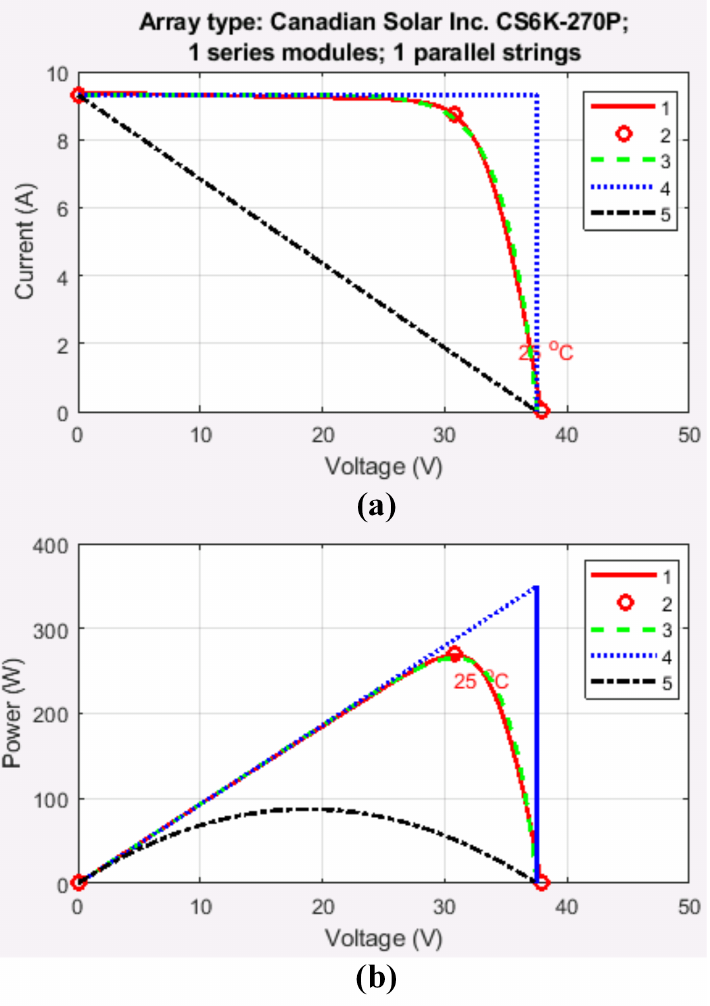
Figure 3. Typical characteristics of power supplies: ( a ) current versus voltage; ( b ) power versus voltage. 1—I-V curve of panel CS6K-270P in Simulink power domain; 2—key points, namely the short circuit current, the maximum power point, and the open circuit voltage; 3—I-V curve of the panel in Simulink spice domain; 4—I-V curve of an ideal stabilized source; 5—I-V curve of a